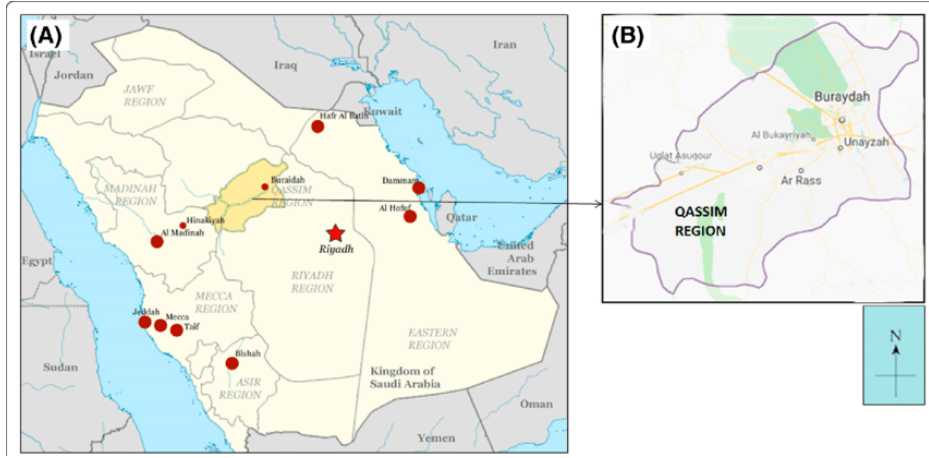
Figure 1. Location of Qassim in Saudi Arabia.